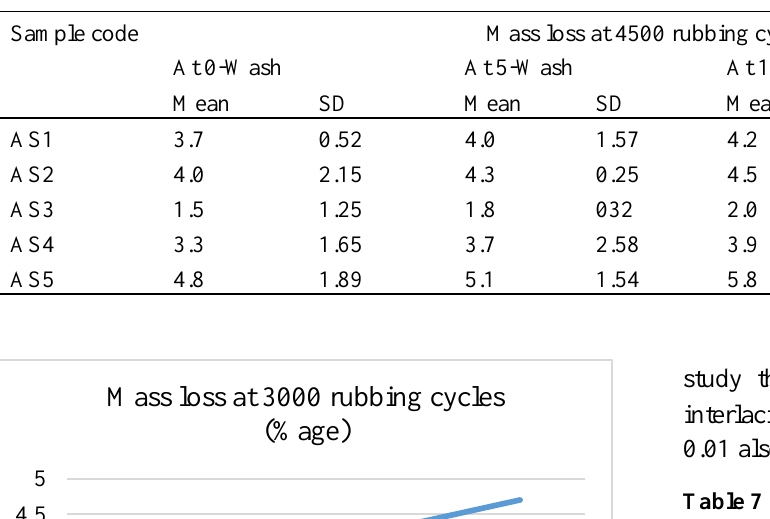
Statistical Analysis of Mass loss at 4500 rubbing